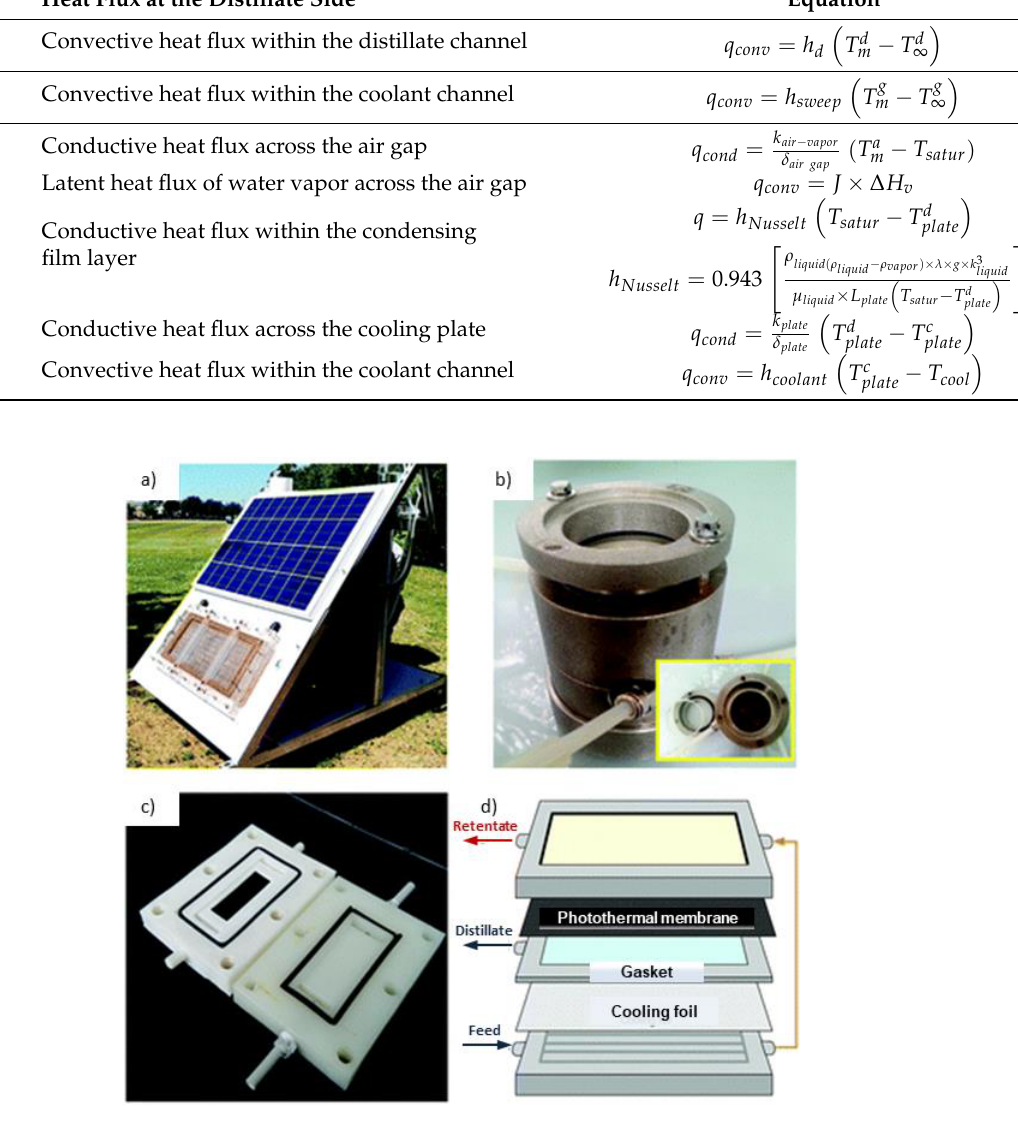
Figure 5. Prototype equipped with a solar panel to provide electric power for the feed and perme- ate/vacuum pump in PVMD ( a ). Membrane modules employed in lab activities for experiments of PVMD ( b ), PDCMD or PSGMD ( c ). Scheme of a membrane module for PAGMD ( d ). Reproduced with permission from Ref. [43]. Copyright 2022 Royal Society of